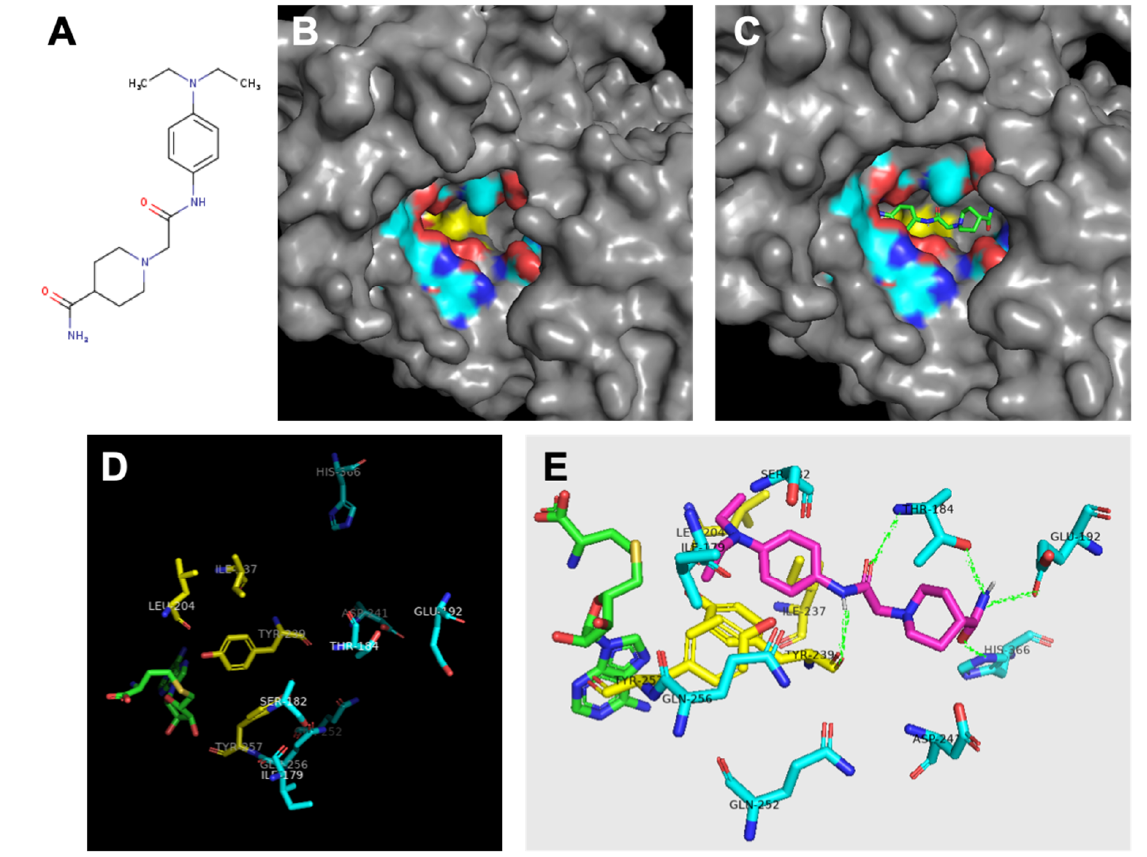
Figure 3. Analysis of SMYD3 binding pocket and predicted inhibitor interactions. Light blue indicates carbons in hydrophilic amino acids, yellow indiiates carbons in hydrophobic amino acids. ( A ) Structure of Inhibitor-4. ( B ) Surface model indicating oily hydrophobic core of binding pocket beneath hydrophilic residues. ( C ) Predicted orientation of Inhibitor-4 in binding pocket. ( D ) Significant residues in binding pocket reveal hydrophobic region (yellow) at interface with cofactor SAH (green) followed by a ring of hydrophilic residues. ( E ) Inhibitor-4 (magenta) predicted interactions with binding pocket residues. Predicted hydrogen bonds shown in green.